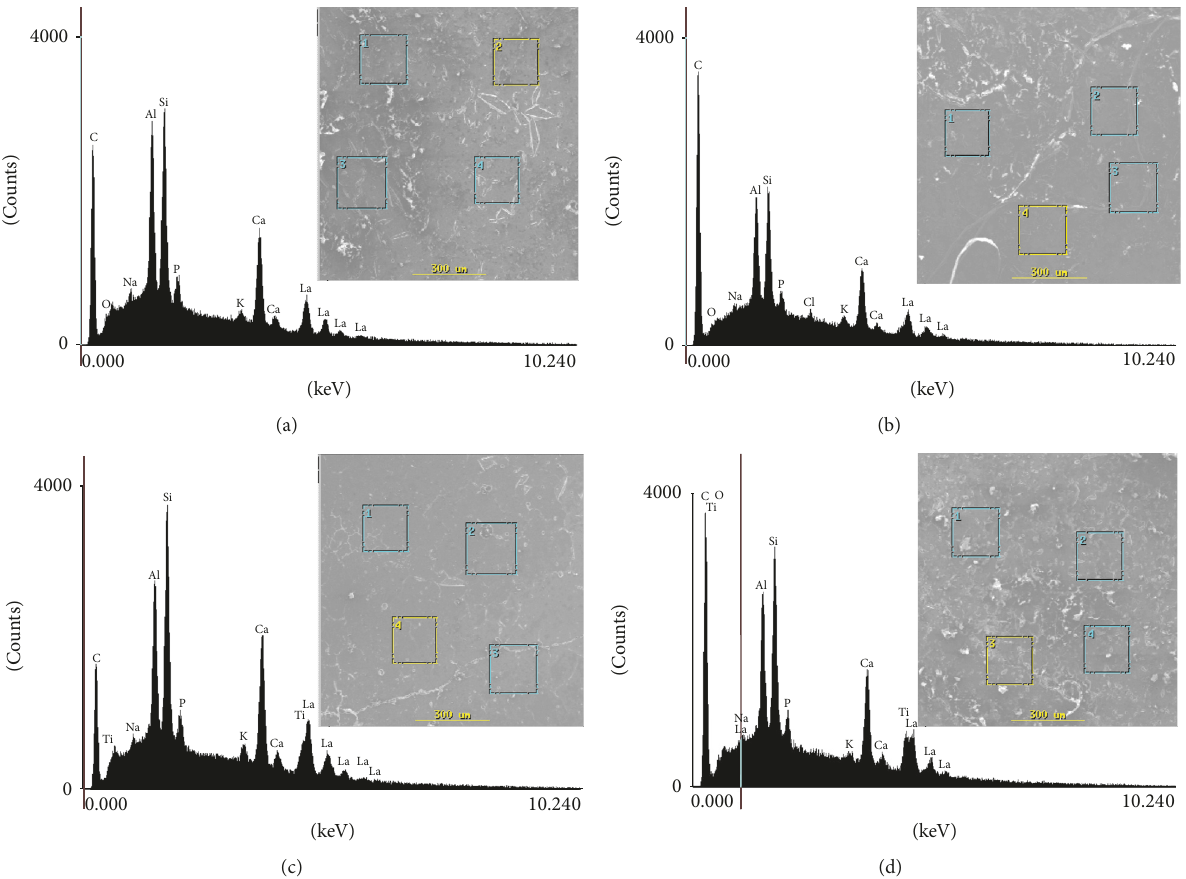
Figure 1: Scanning electron microscopic microphotographs selected areas for the experimental groups (original magnification 100x) and their respective chemical composition by energy dispersive spectroscopy. (a) Control (KM); (b) KM + 3% TiO 2 ; (c) KM + 5% TiO 2 ; (d) KM + 7% TiO 2 .